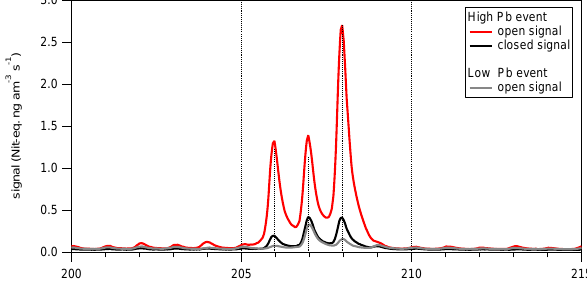
Fig. 5. Scatter plots of 206 Pb + vs. 208 Pb + signals from the C-AMS. Black line corresponds to the expected isotopic ratio (deLaeter et al.,